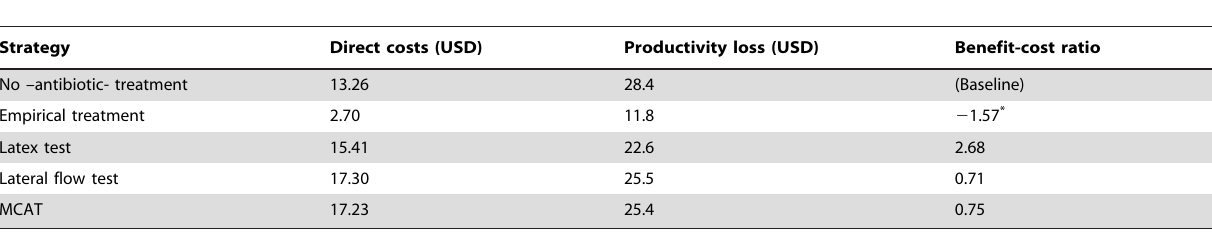
Table 6. Benefit-cost ratios for the different strategies.